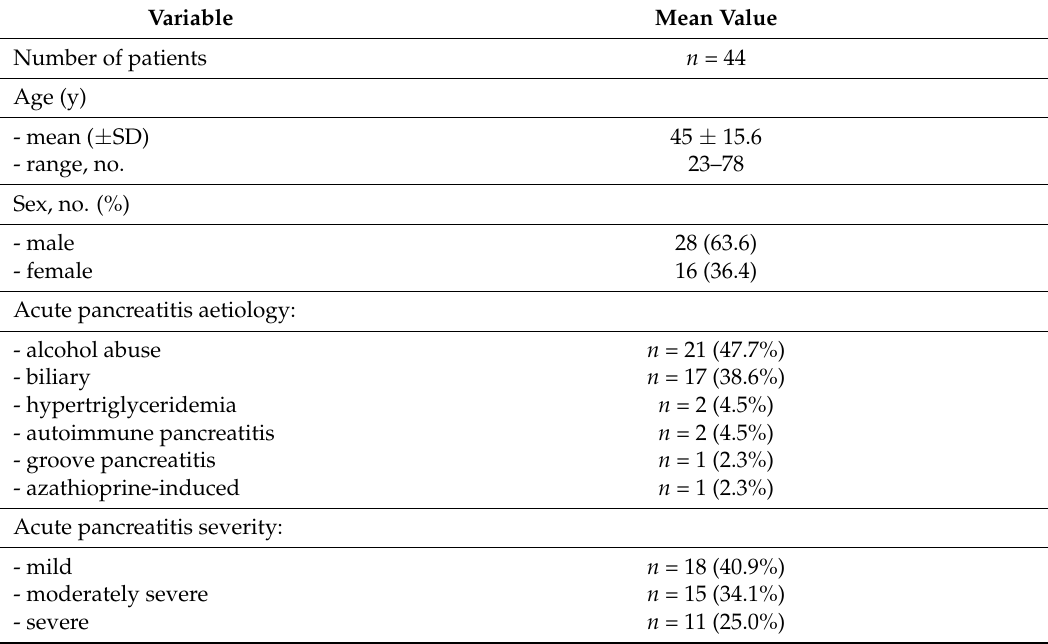
Table 1. Baseline characteristic of the patients participating in the study. Number of patients, age, acute pancreatitis aetiology, disease severity, and baseline laboratory results were